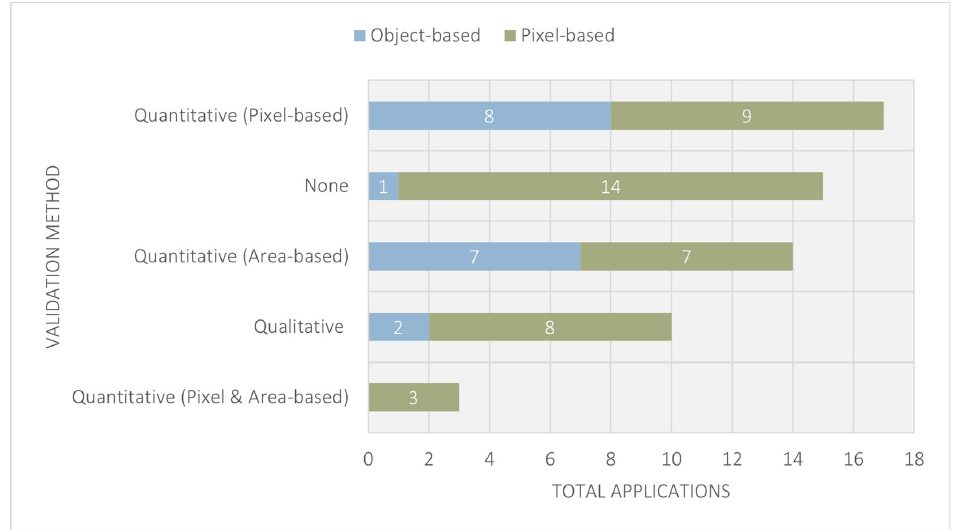
Figure 11. Comparison of the validation methods reported in the selected articles and the analysis unit.